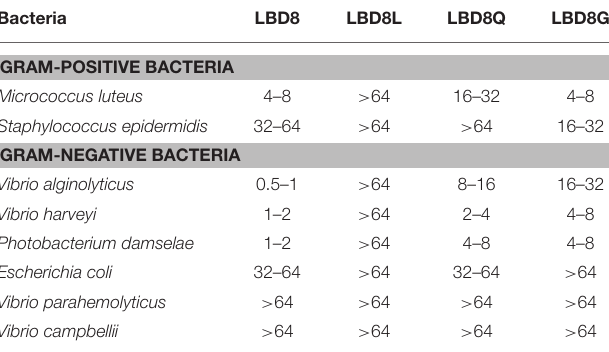
TABLE 3 | Minimal inhibitory concentration ( µ M) of synthetic LBD8 and modified peptides on different bacteria.